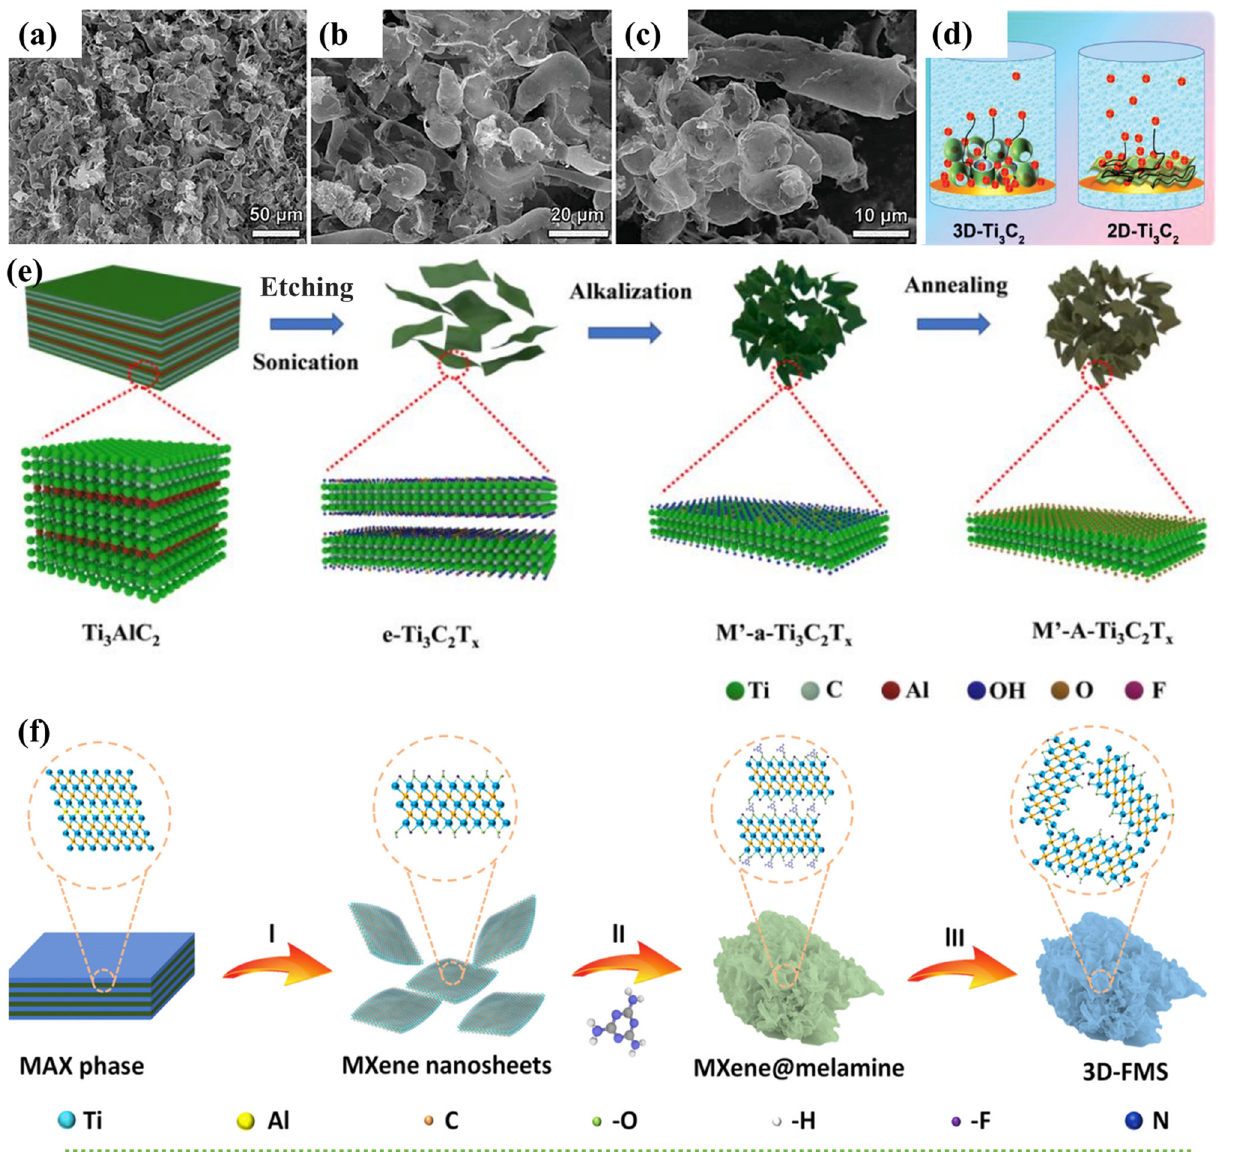
Figure 16. ( a , b ) SEM images. ( c ) An exemplification of ion transport in 3D and 2D Ti 3 C 2 electrodes [125]. ( d ) An exemplification of fabrication [126] and ( e , f ) the synthesis of 3D-FMS [127].